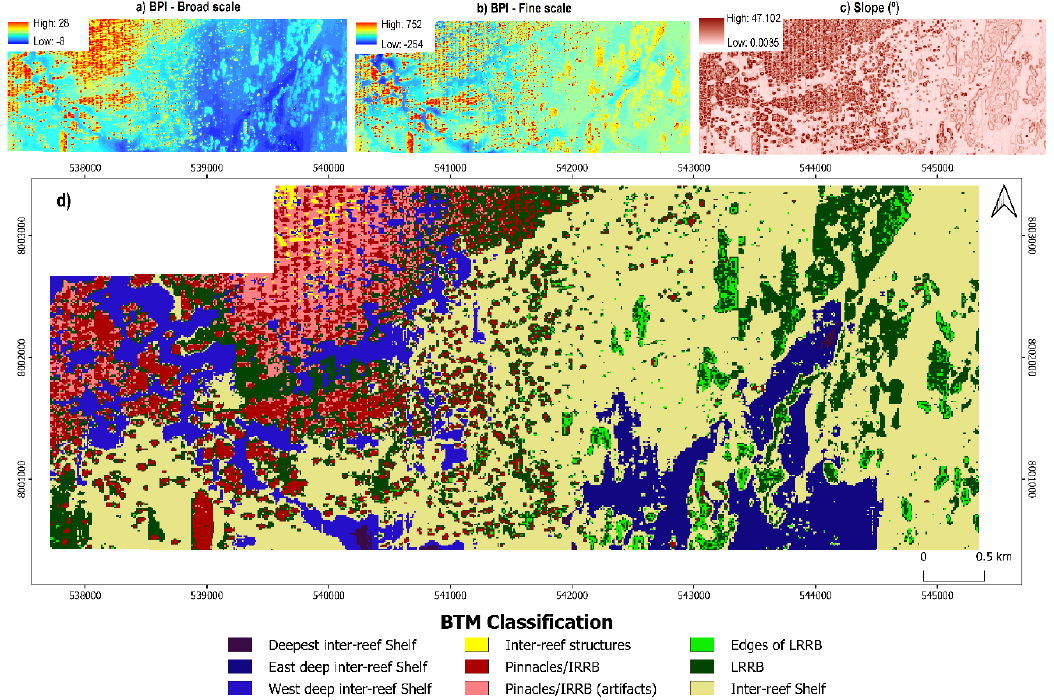
Figure 4. Products generated with the BTM toolbox: ( a ) BPI broad scale; ( b ) BPI fine scale; ( c ) Slope; ( d ) BTM classification.